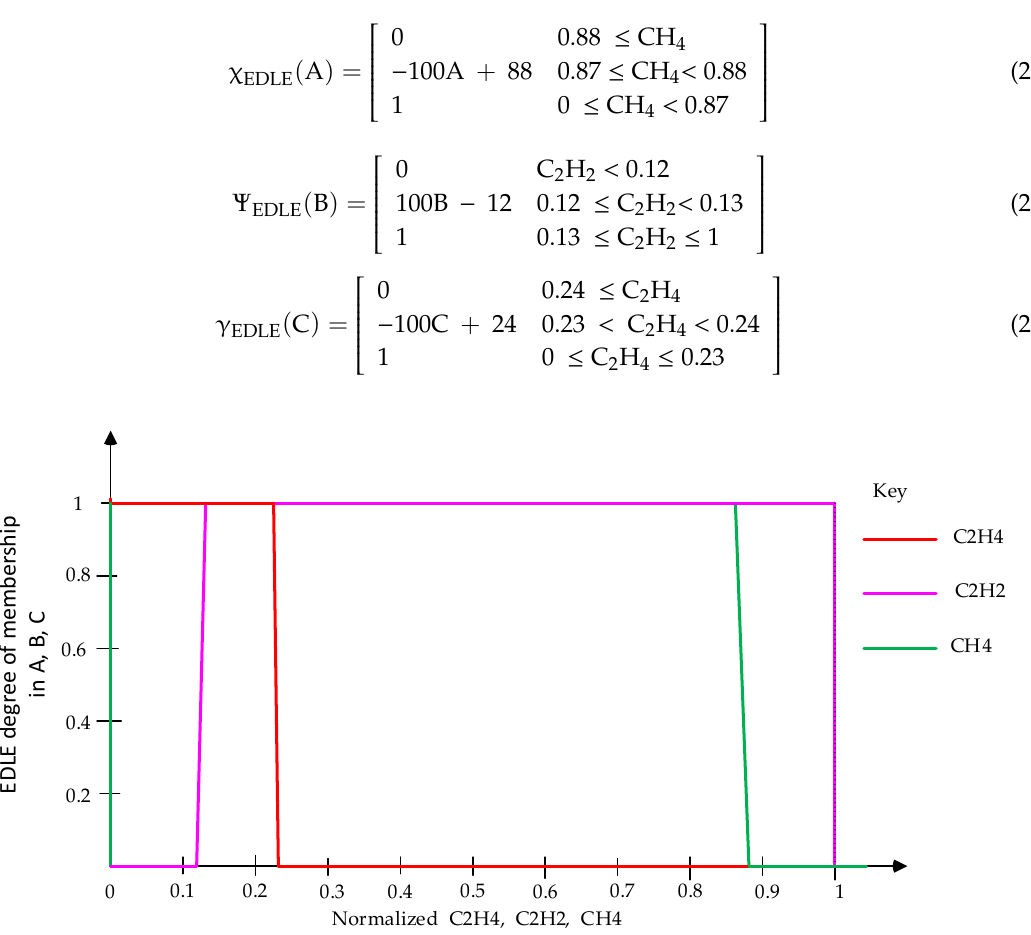
Figure 7. Fuzzy mapping curves for synthesizing electrical discharges of low energy (EDLE)